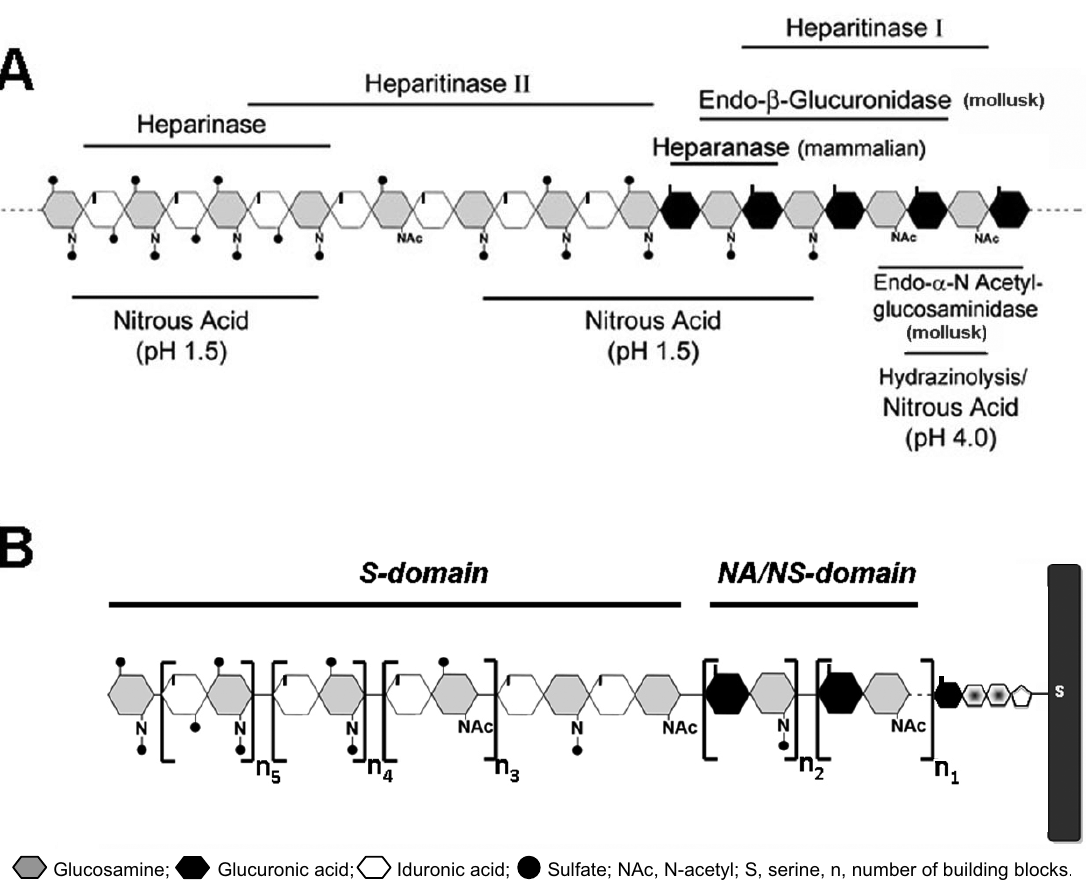
Fig. 1 – Heparan Sulfate Proteoglycan Structural Characteristics. (A) Hypothetical heparin/heparan sulfate chain and site of action of different enzymatic and chemical depolymerization procedures. (B) Proposed structure for heparan sulfate from different origins. S-domain represents iduronic acid containing disaccharides and NA/NS-domain represents glucuronic acid containing disaccharides bearing glucosamine N-sulfate or N-acetylglucosamine.